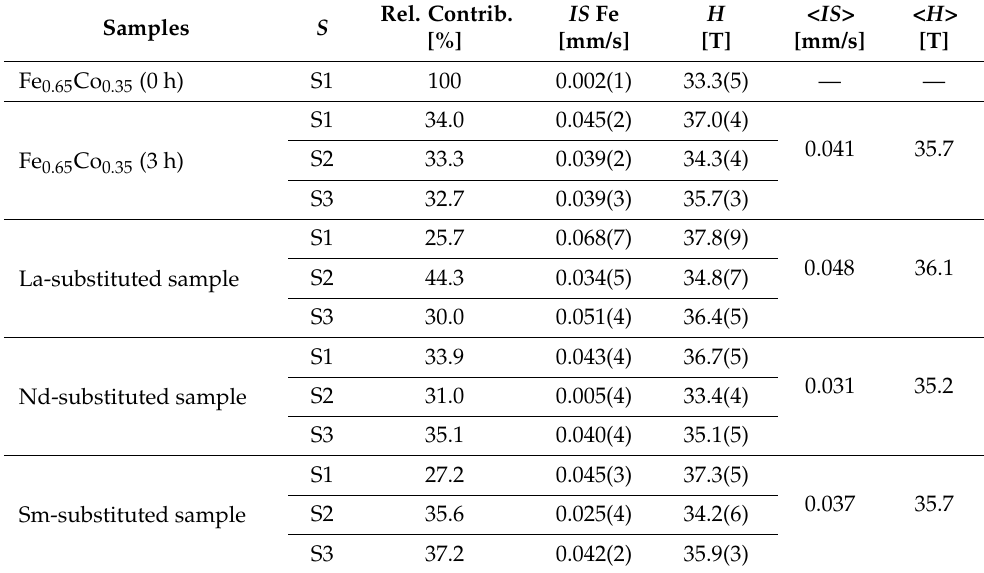
Table 2. Hyperfine interactions parameters for each sextet ( S ) (relative contribution and isomer shift with respect to Fe – IS ; hyperfine magnetic field – H ) for each component and their respective mean values (< IS >, < H >) obtained from the fits of measured Mössbauer spectra. IS Fe Rel. Contrib. Samples S [%]